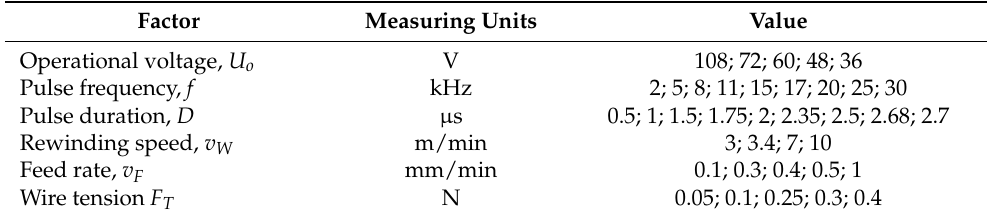
Table 2. Range of electrical discharge machining